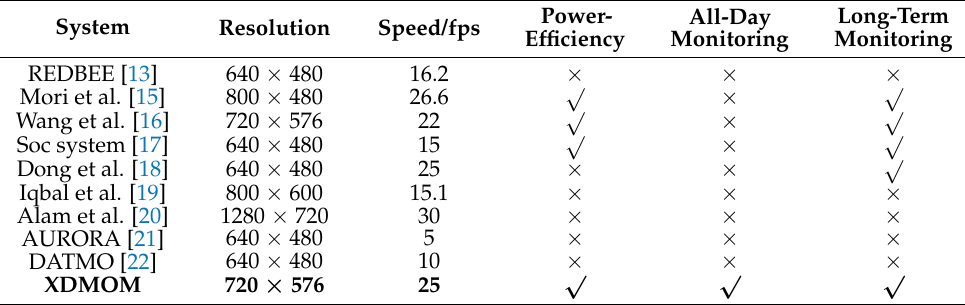
Table 1. Performance analysis of the state-of-the-art video surveillance